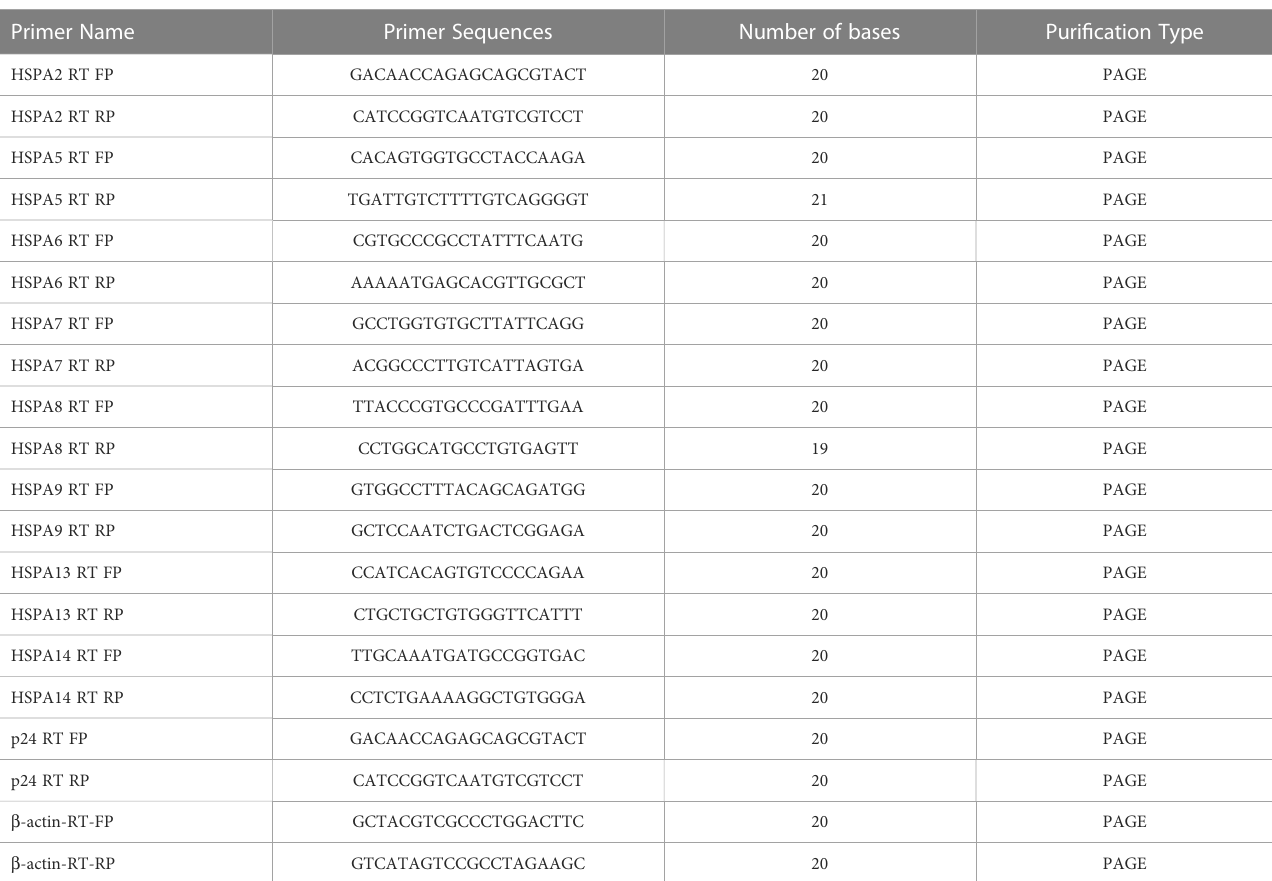
TABLE 4 List of the primers used for qRT-PCR